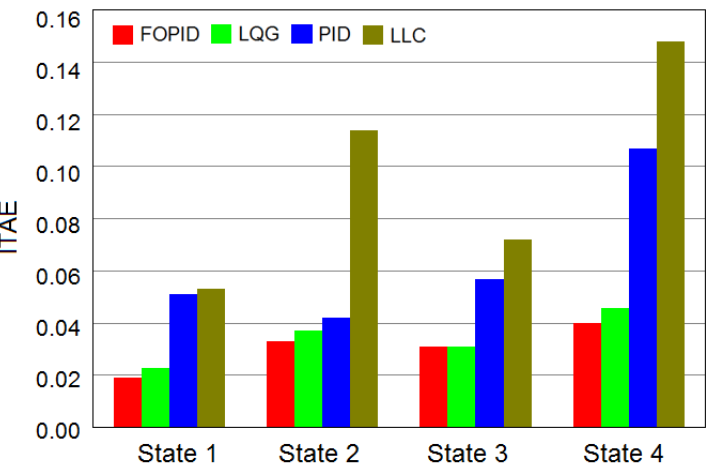
Figure 16. ITAE index for scenario 2.